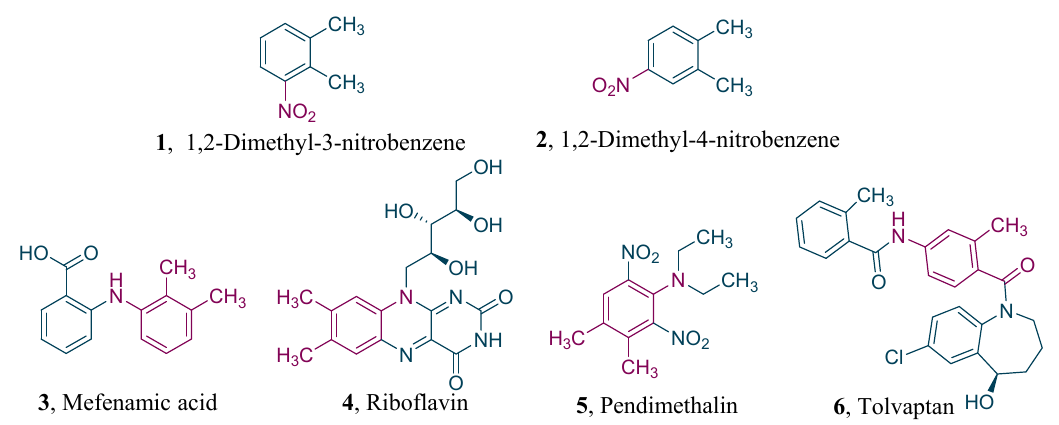
Figure 1. Structures of nitro- o -xylenes and related downstream products.